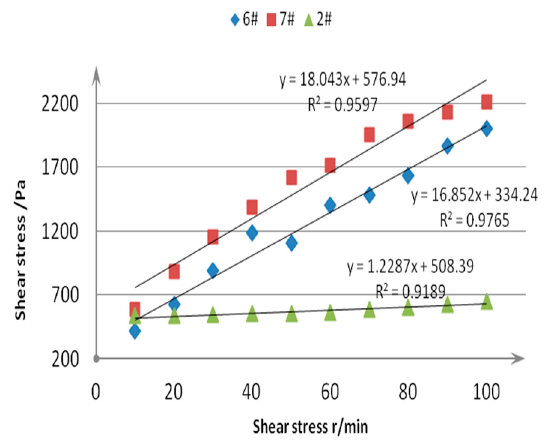
Figure 12. The flow properties (shear stress-shear rate variation) of samples 2, 6, and 7.